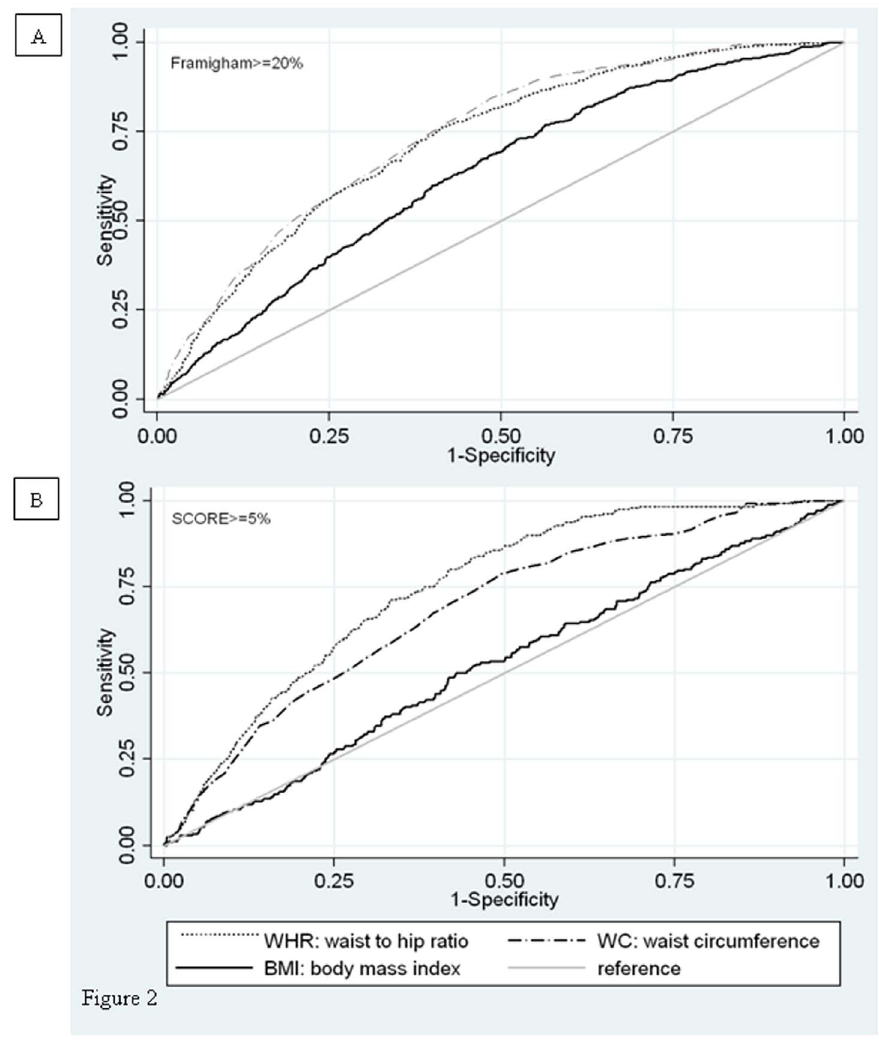
Figure 2. BMI, WC and WHR in detecting Framingham risk score ( $ 20%) and SCORE Project ( $ 5%). A.-The AUC was 0.739 (95%CI 0.719– 0.759) for WC; 0.724 (95%CI 0.704–0.745) for WHR and 0.631 (95%CI 0.608–0.653) for BMI (p , 0.001). B. - The AUC was 0.688 (95%CI 0.655–0.721) for WC; 0.746 (95%CI 0.719–0.773 for WHR, 0.523 (95%CI 0.486–0.561) for BMI (p , 0.001).